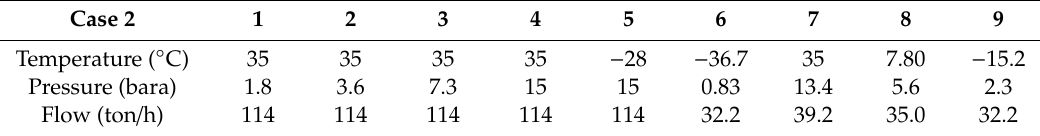
Table A2. Mass balance for the Case 2 verification model, numbering as Figure 1b.